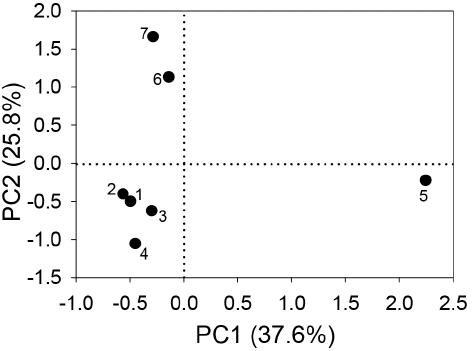
Figure 5. Two-dimensional scatter plot of sampling sites on the two principal components (PC). Sites are clustered along the x-axis (Factor 1) in site 5 and all other sites and along the y-axis (Factor 2) in sites 6, 7 and 1–5. See text and Table 5 for which parameters represent best each of the factors.